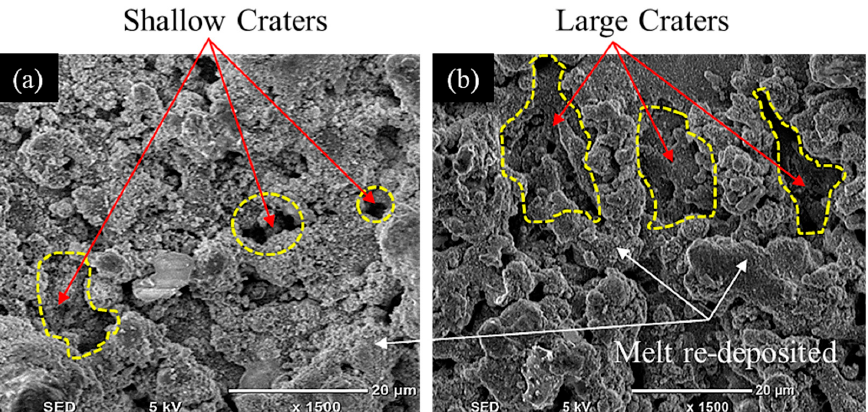
Figure 7. Micrographs representing surface morphology of Ti-6Al-4V specimens machined with Al-electrode at two different tool polarities: ( a ) positive polarity; ( b ) negative polarity.